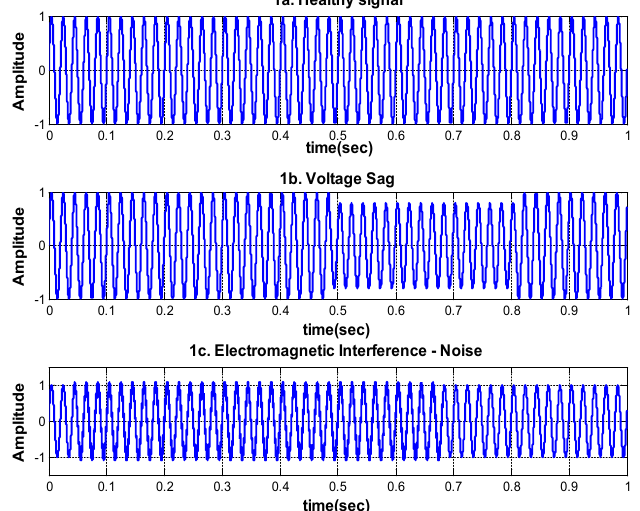
Fig. 1. Healthy signal (1a), normalized voltage sag (1b) and EMI normalized voltage signal (1c) (L1-N / phase A) generated with Tektronix